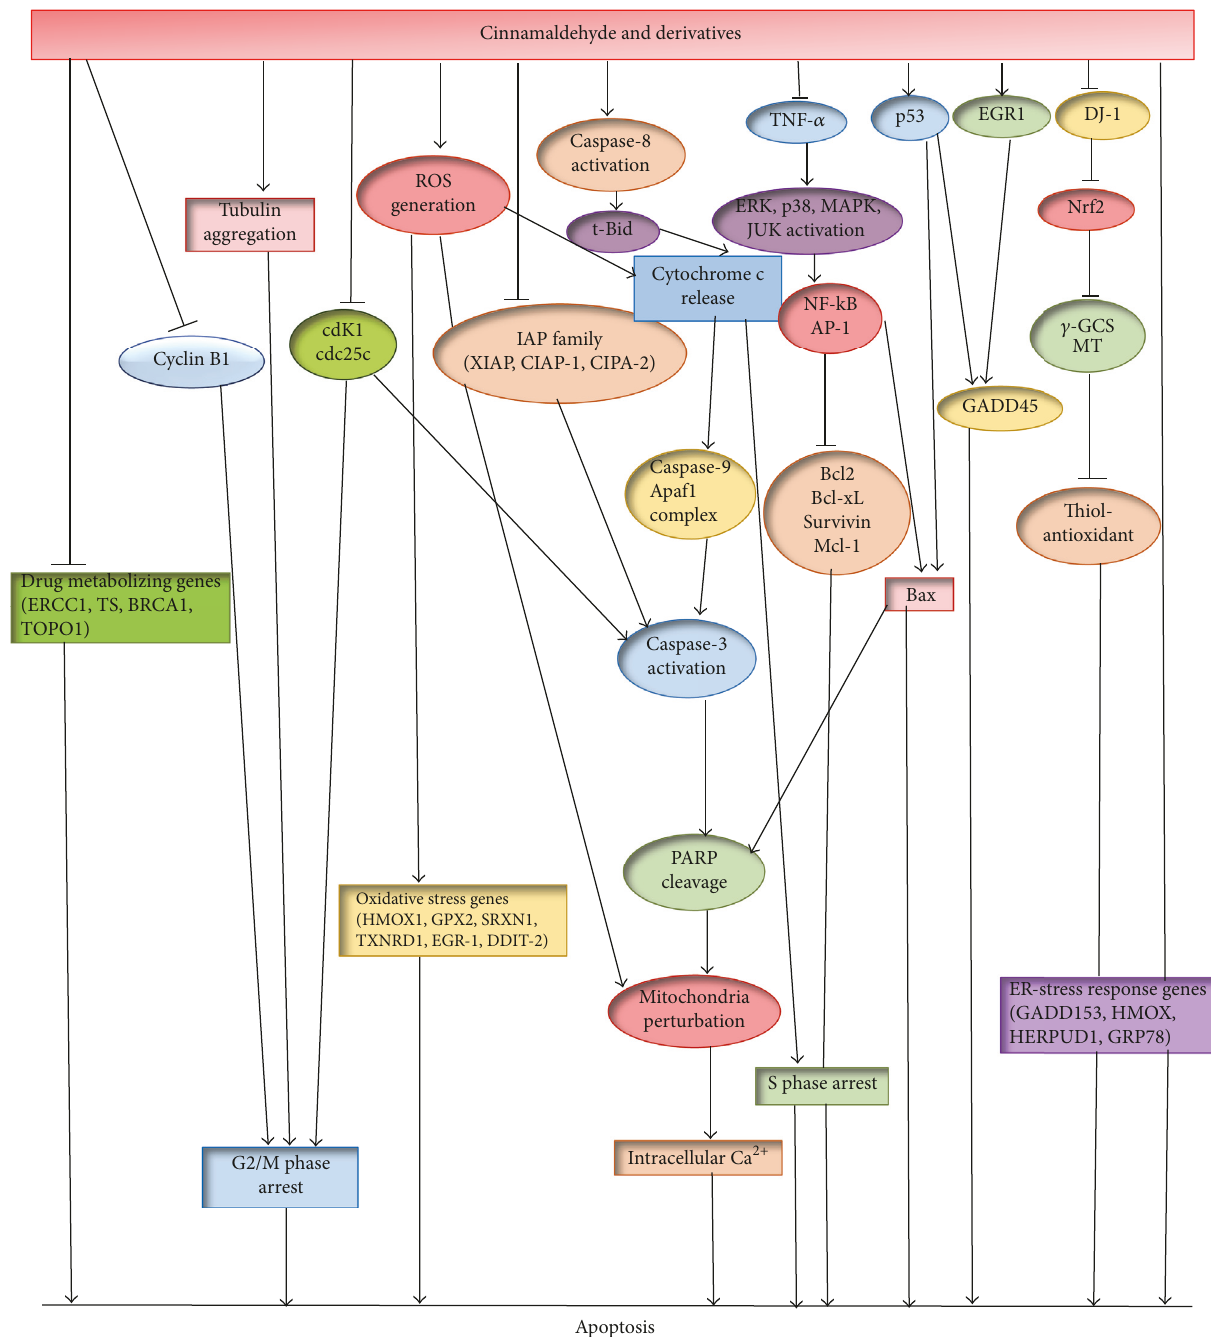
Figure 4: Schematic diagram of the mechanisms of action by which cinnamaldehyde and its derivatives induce apoptosis in cancer cells (adapted from Phytother. Res. 30: 754–767; DOI: 10.1002/ptr.5592, 2016).